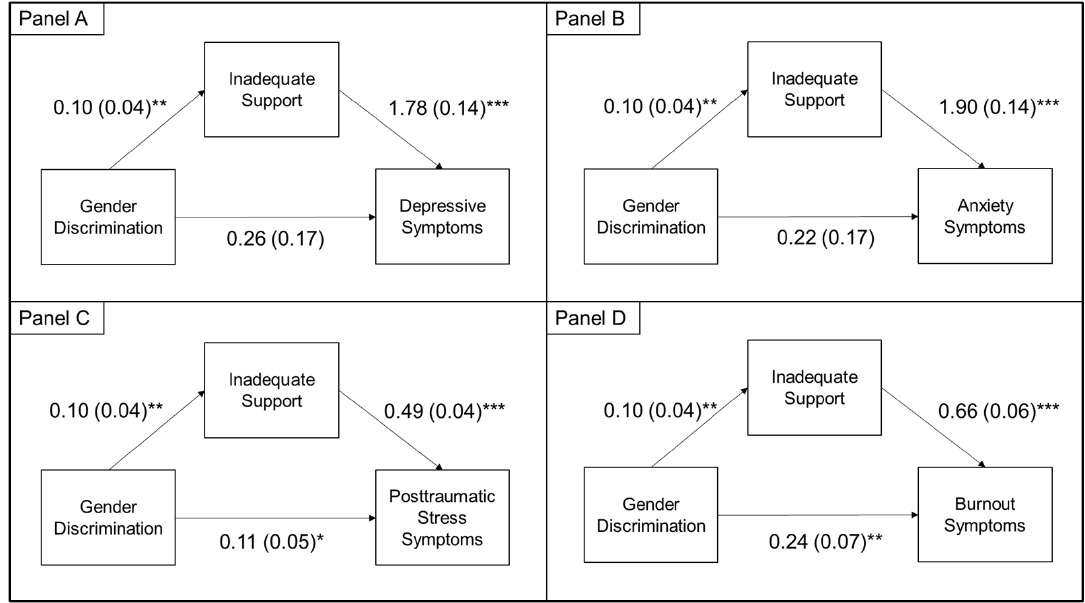
Figure 2. Indirect effects of gender discrimination on symptoms of depression (Panel A ), anxiety (Panel B ), posttraumatic stress (Panel C ), and burnout (Panel D ) via inadequate social support. The indirect effects analysis controlled for age, gender, race/ethnicity, marital status, profession, pre-pandemic mental health diagnosis, income, family/friend being diagnosed with COVID-19, childcare needs, housing change, frontline status, change in roles, change in work hours, and racial discrimination. * p < .05 and ≥ .01; ** p < .01 and ≥ .001; *** p <